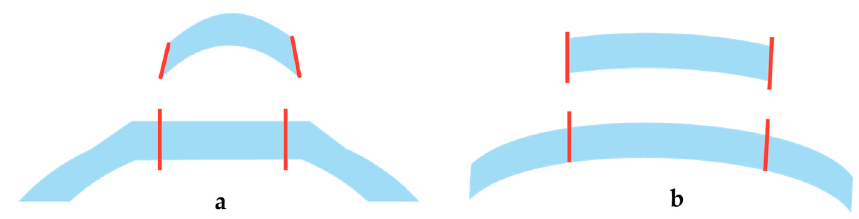
Figure 13. Comparison of donor and recipient trephination profiles: ( a ) applanation, ( b ) liquid optic interface.